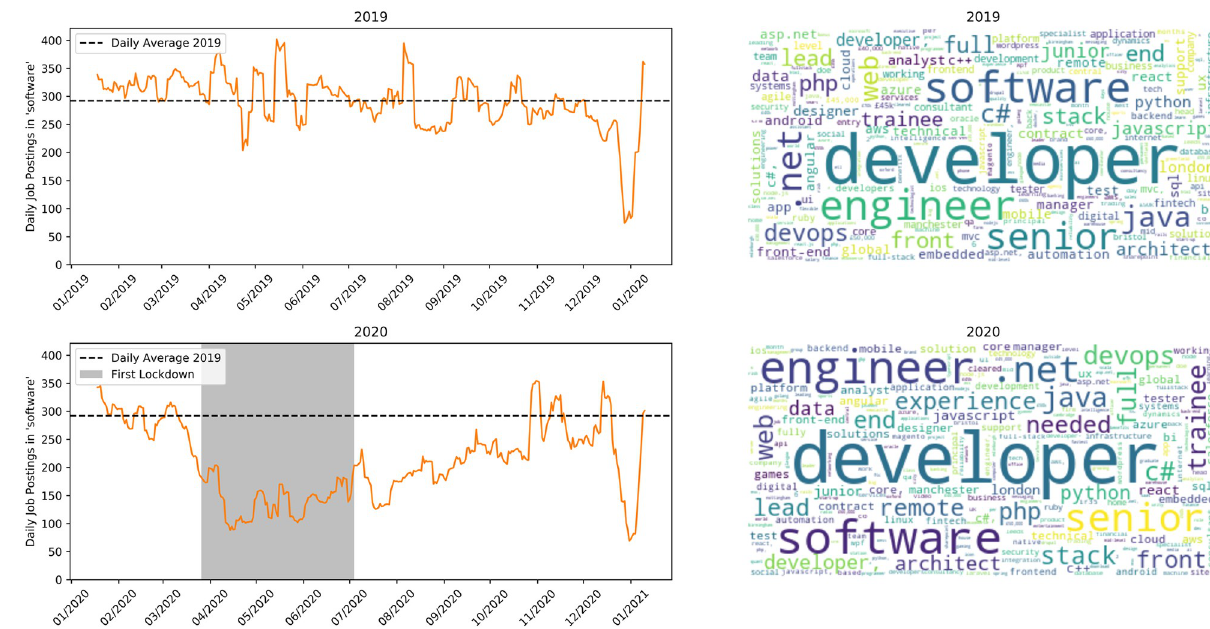
Fig 9. Jobs matching ‘software’. Top row is 2019, bottom is 2020.